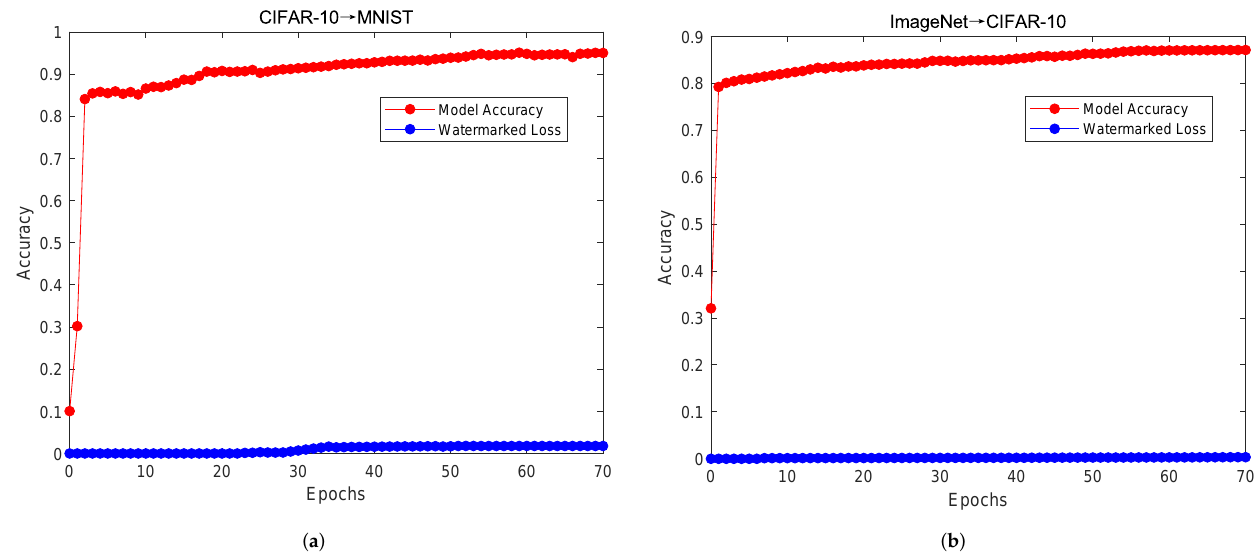
Figure 6. Changes in model accuracy and watermark loss in watermarked models as the number of fine-tuning epochs increases.